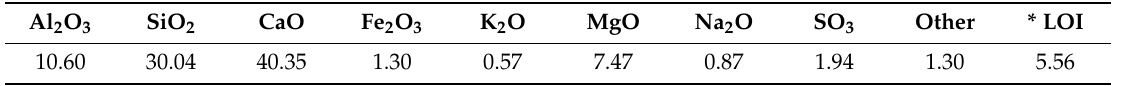
Table 1. Chemical composition of blast furnace slag (BFS) (wt %).